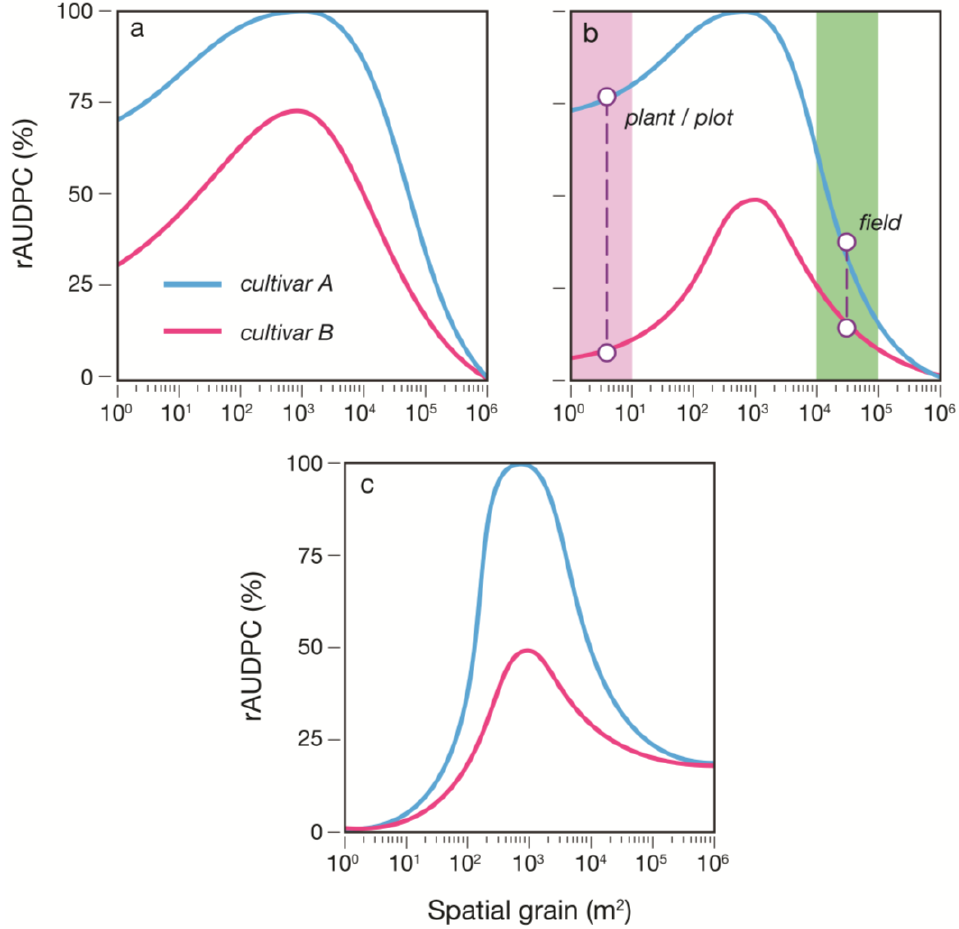
Figure 3. Relative area under the disease progress curve (rAUDPC) for simulated epidemics in landscapes where the spatial grain (cell dimensions, m 2 ) is systematically increased, under three landscape scenarios: ( a ) an aggregated and abundant host distribution; ( b ) a randomly distributed and abundant host distribution; and ( c ) a randomly distributed and sparse host distribution. The blue curve represents a relatively susceptible crop variety and the pink curve a relatively resistant variety, with an infection efficiency, ε (-), half the value of the former. Shaded areas delineate some characteristic domains of scale for phenotyping trials (purple) versus commercial production settings